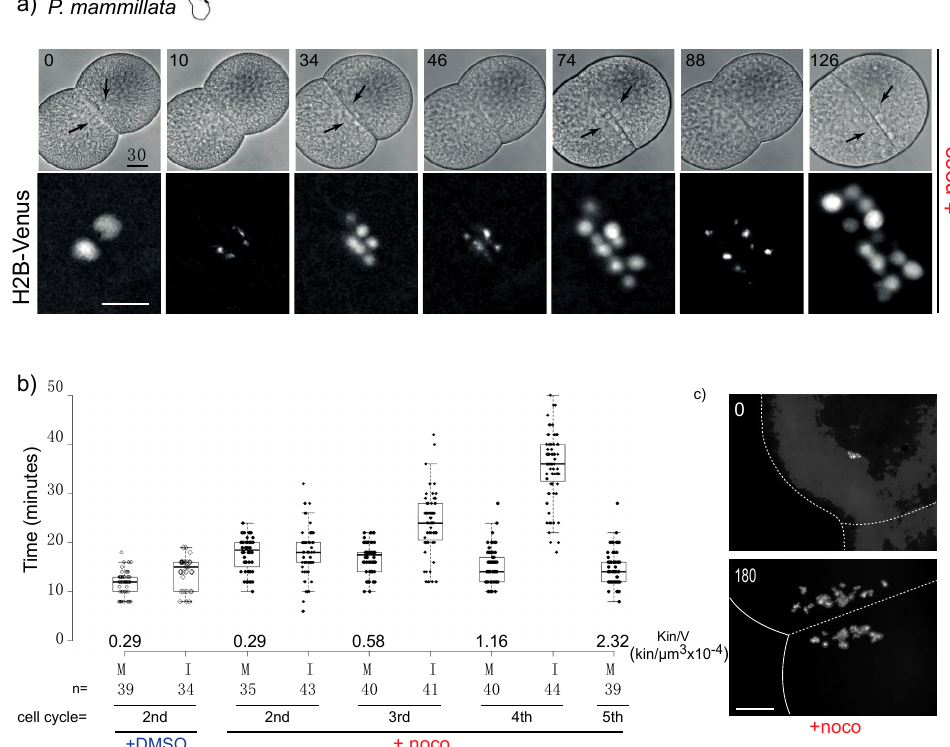
Figure 3. P. mammillata 2-cell embryos do not arrest in mitosis in the absence of spindle microtubules. ( a ) Selected frames from a time-lapse movie of a P. mammillata embryo expressing the DNA reporter, H2B-Venus, treated with 10 µM nocodazole after first cleavage. Numbers indicate minutes after treatment. Arrows indicate nuclei visible in bright field optics. See movie 1. ( b ) Duration of mitosis (M, NEB to NER) and interphase (I, NER to NEB) in P. mammillata embryos treated with DMSO or nocodazole. Kin/V indicates kinetochore to cell volume ratio at each cell cycle starting from fertilization (1st is 1-cell mitosis; 2nd is 2-cell mitosis). Box plot parameters as in Figure 2b. In nocodazole-treated embryos the amount of DNA increases due to subsequent rounds of DNA replication without intervening cytokinesis. Duration of mitosis in control DMSO-treated embryos is constant in all four analyzed cell cycles. ( c ) DAPI (4 ′ ,6-diamidine-2 ′ -phenylindole dihydrochloride)-stained chromosome spreads from DMSO and nocodazole-treated (180 min) P. mammillata embryos. After 180 min nocodazole treatment, embryos have undergone 4 more cell cycles and have 4 times more DNA than at time 0. In the absence of microtubules, the nuclei which form around chromosome clusters (karyomeres) do not fuse and are dispersed over time by cytoplasmic flow (in ( a) and ( c )). Scale bar = 30 µm.